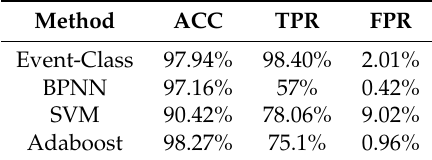
Table 6. Comparison of event-class predictor with other common